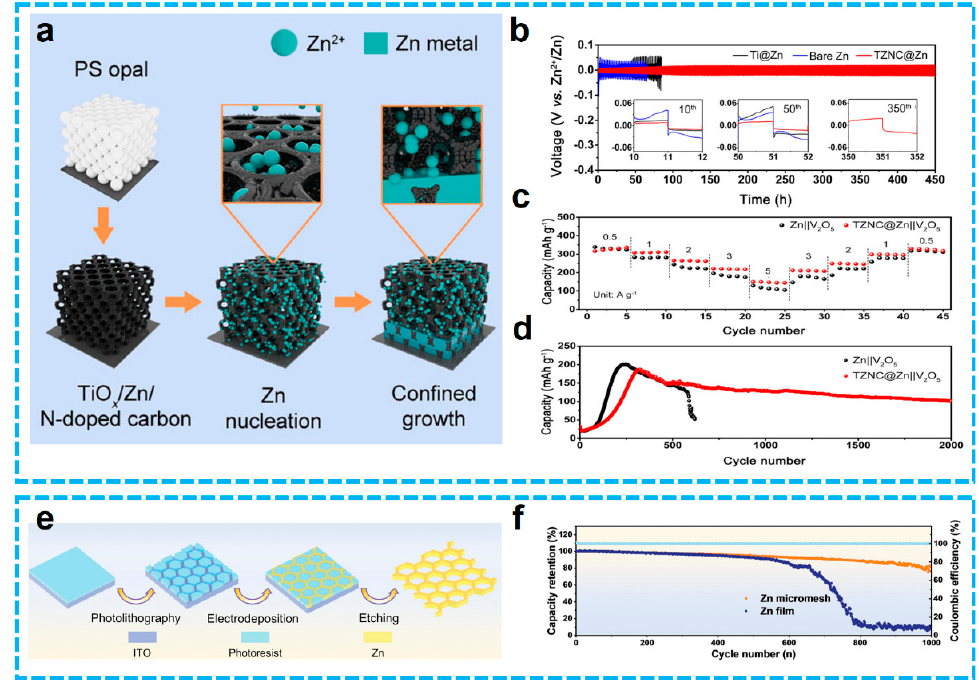
Figure 2. ( a ) Schematic illustration of the procedure for the TZNC IO and Zn deposition on the TZNC host Reproduced with permission from reference [31]. ( b ) Voltage profiles of Zn plating/stripping in symmetric batteries with a capacity of 1 mAh cm − 2 at 1 mA cm − 2 Reproduced with permission from reference [31]. ( c ) Rate performances and ( d ) cycling performance at 5 A g − 1 for TZNC@Zn||V 2 O 5 and Zn||V 2 O 5 full cells Reproduced with permission from reference [38]. ( e ) Schematic illustration of the fabrication process of Zn-based IO structure Reproduced with permission from reference [32]. Reproduced with permission from reference. ( f ) Long-term cycling test of ZM//PVO and ZF//PVO pouch batteries at the current density of 10 A g − 1 Reproduced with permission from reference